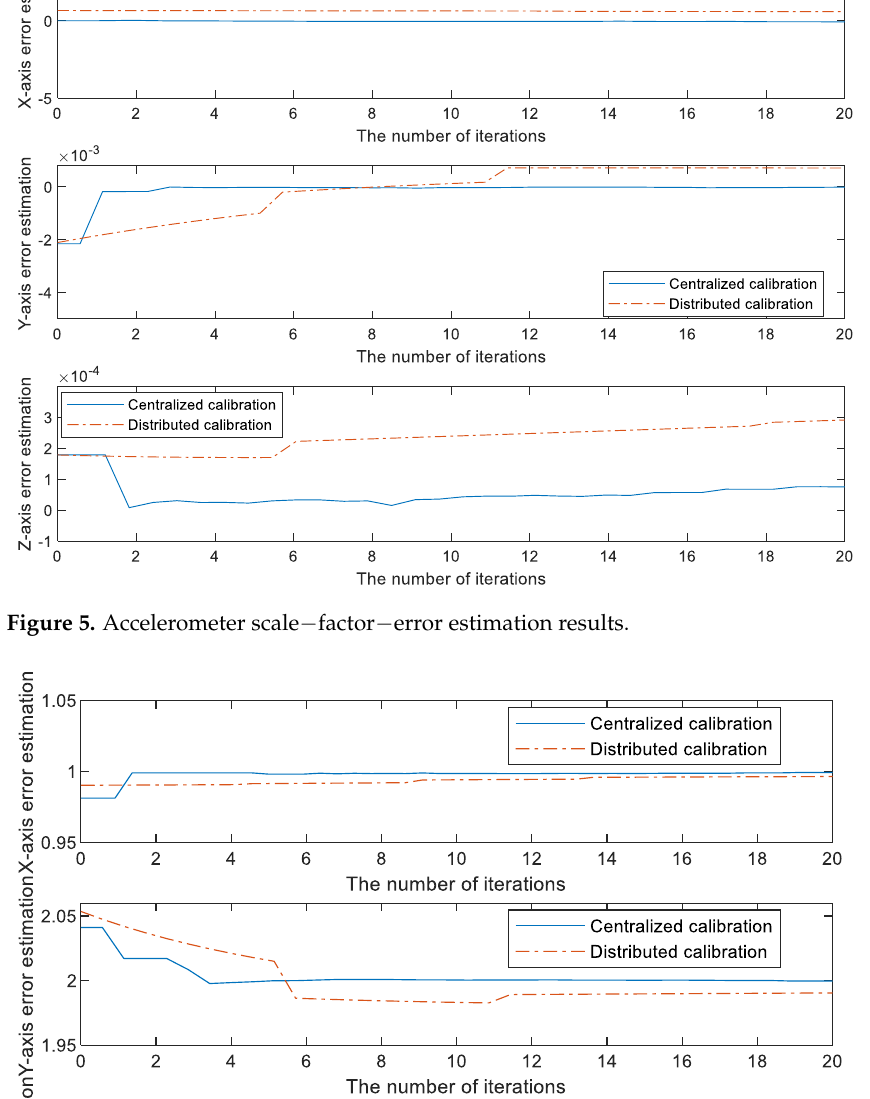
Figure 4. Accelerometer installation − error estimation results.